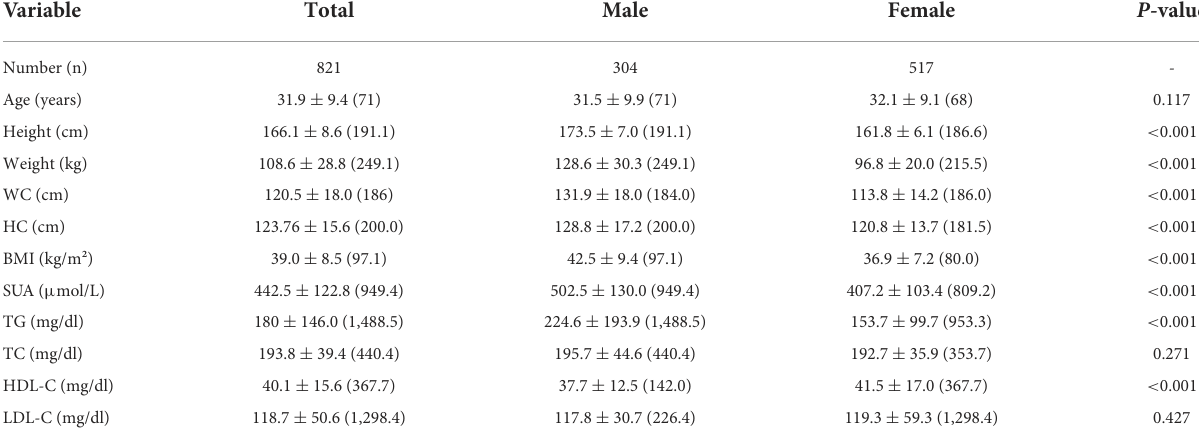
TABLE 1 Baseline characteristics and SUA level of the study cohort.